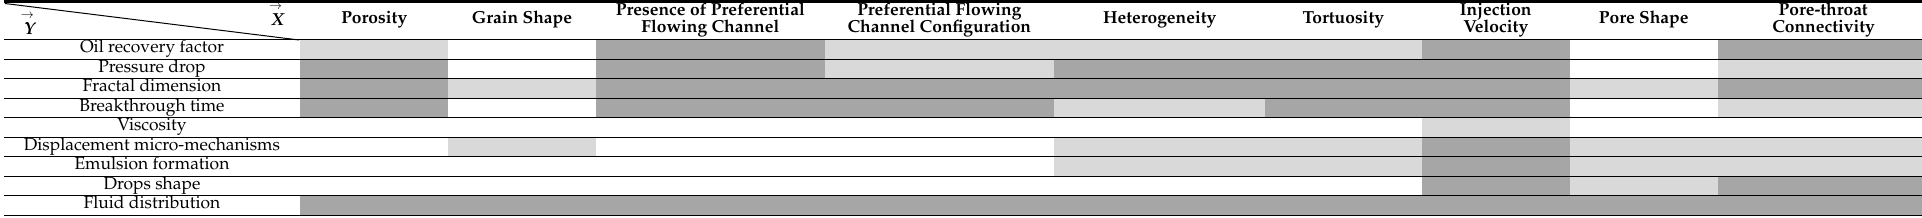
Table 1. Relation between modifiable respectively.